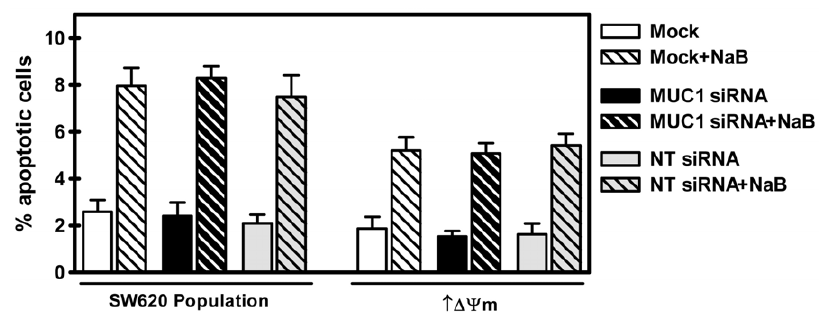
Figure 5. siRNA mediated down-regulation of MUC1 does not affect intrinsic Dy m-linked sensitivity to butyrate (NaB) induced apoptosis. Cells were mock, MUC1- or NT-siRNA transfected and 48 hours later and then exposed to 5 mM NaB for 24 hours. Percentage of apoptotic cells was determined by PI staining and flow cytometry.